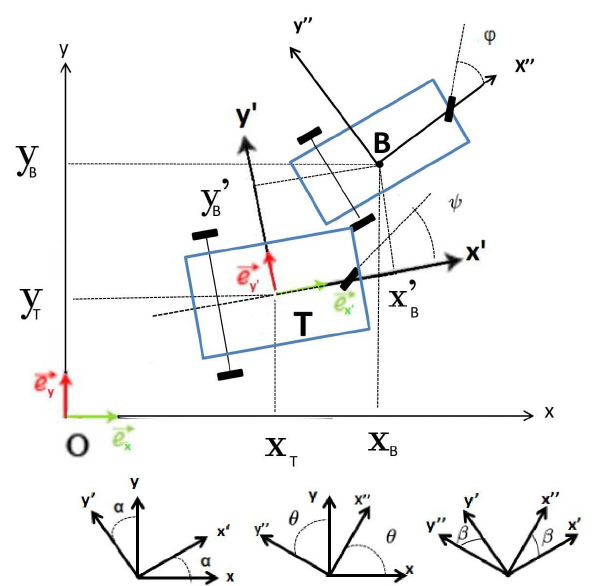
Figure 2. Two vehicle tracker (T) and tracked (B) scenario, and the different vehicle coordinate